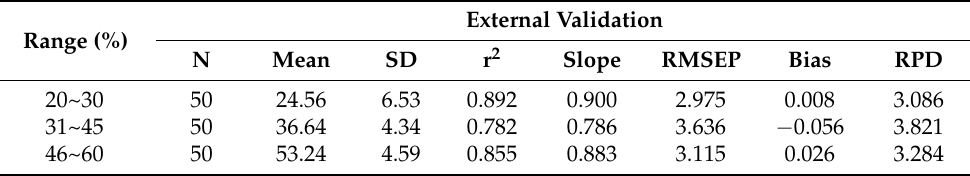
Table 3. External validation statistics in NIRS equations for determining amylose content in single maize seed. External Validation Range (%) N Mean SD r 2 Slope RMSEP Bias RPD 20~30 50 24.56 6.53 0.892 0.900 2.975 0.008 3.086